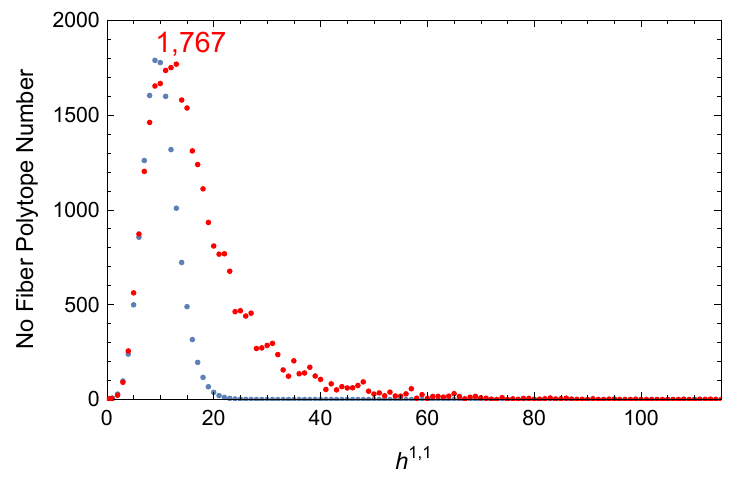
Figure 4 . Illustration of the \fat tail" in the number of 4D re(cid:13)exive polytopes without 2D re(cid:13)exive toric (cid:12)bers (red), compared to exponentially suppressed prediction (gray) based on heuristic analysis of elliptic (cid:12)brations for Calabi-Yau threefolds from